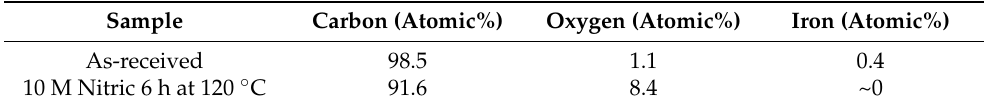
Table 6. Normalized atomic percentage from XPS results for as-received and 10 M nitric acid 120 ◦ C 6 h CNTs.